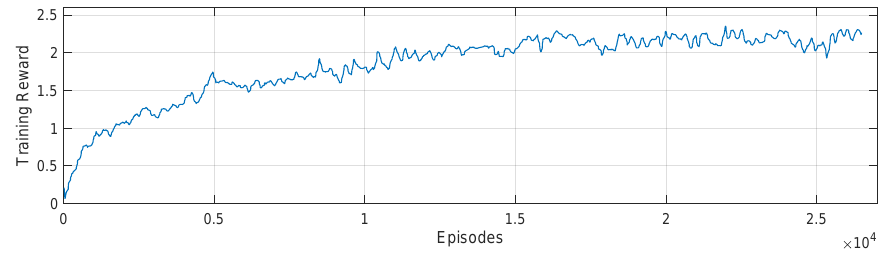
Figure 7. Evaluation of the reward during training.